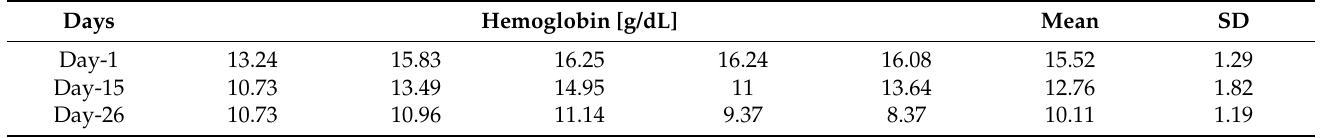
Table 3. Hemoglobin levels of rats during development of anemia (Phase-I).